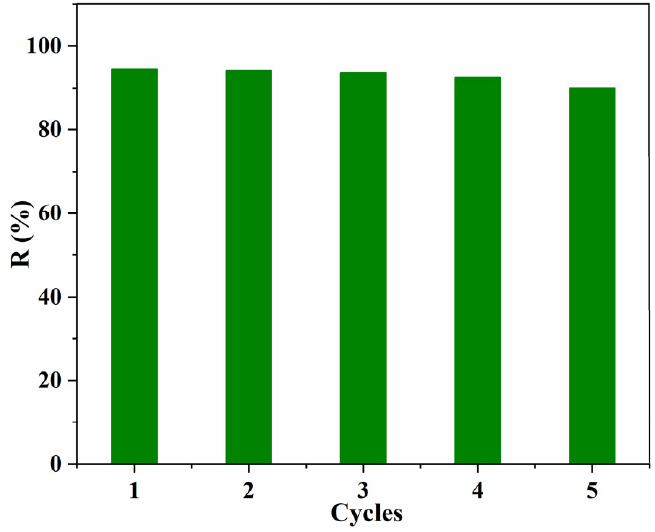
Figure 11. Effect of recycling times on the adsorption capacity Q (mg/g) with 40%Tan/SA beads ( C 0 . = 10 mg/L, pH = 12, T = 45 °C, t = 4 h). Table 3. Comparison of the MB removal performance with similar